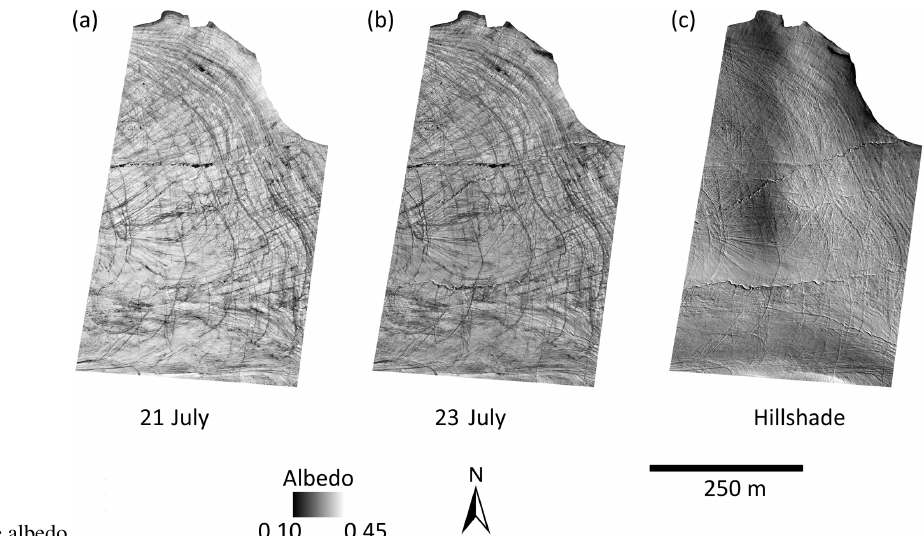
Figure 3. Albedo was derived from UAV imagery using average values from RGB bands and scaling the lower and upper bounds to match the albedo of bare rocks (based on Ryan et al., 2017) and the average albedo measured on Fountain Glacier during the study period. (a) 21 July albedo values. (b) 23 July albedo values. (c) A hillshade model of the study area based on the DSM from 21 July.